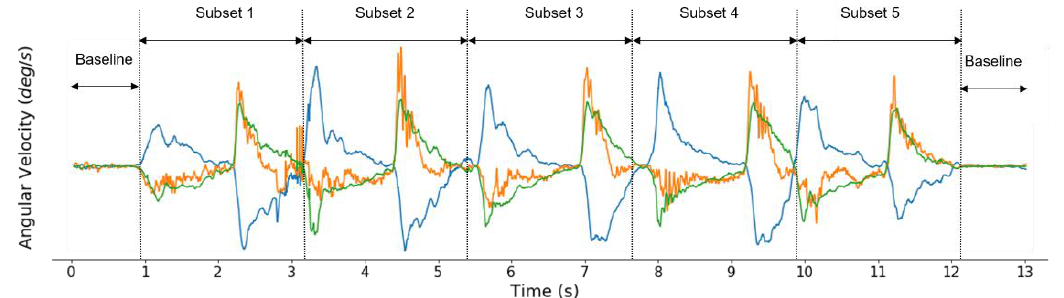
Figure 2. Baseline recordings and subsets of elbow flexion–extension movement cycles.